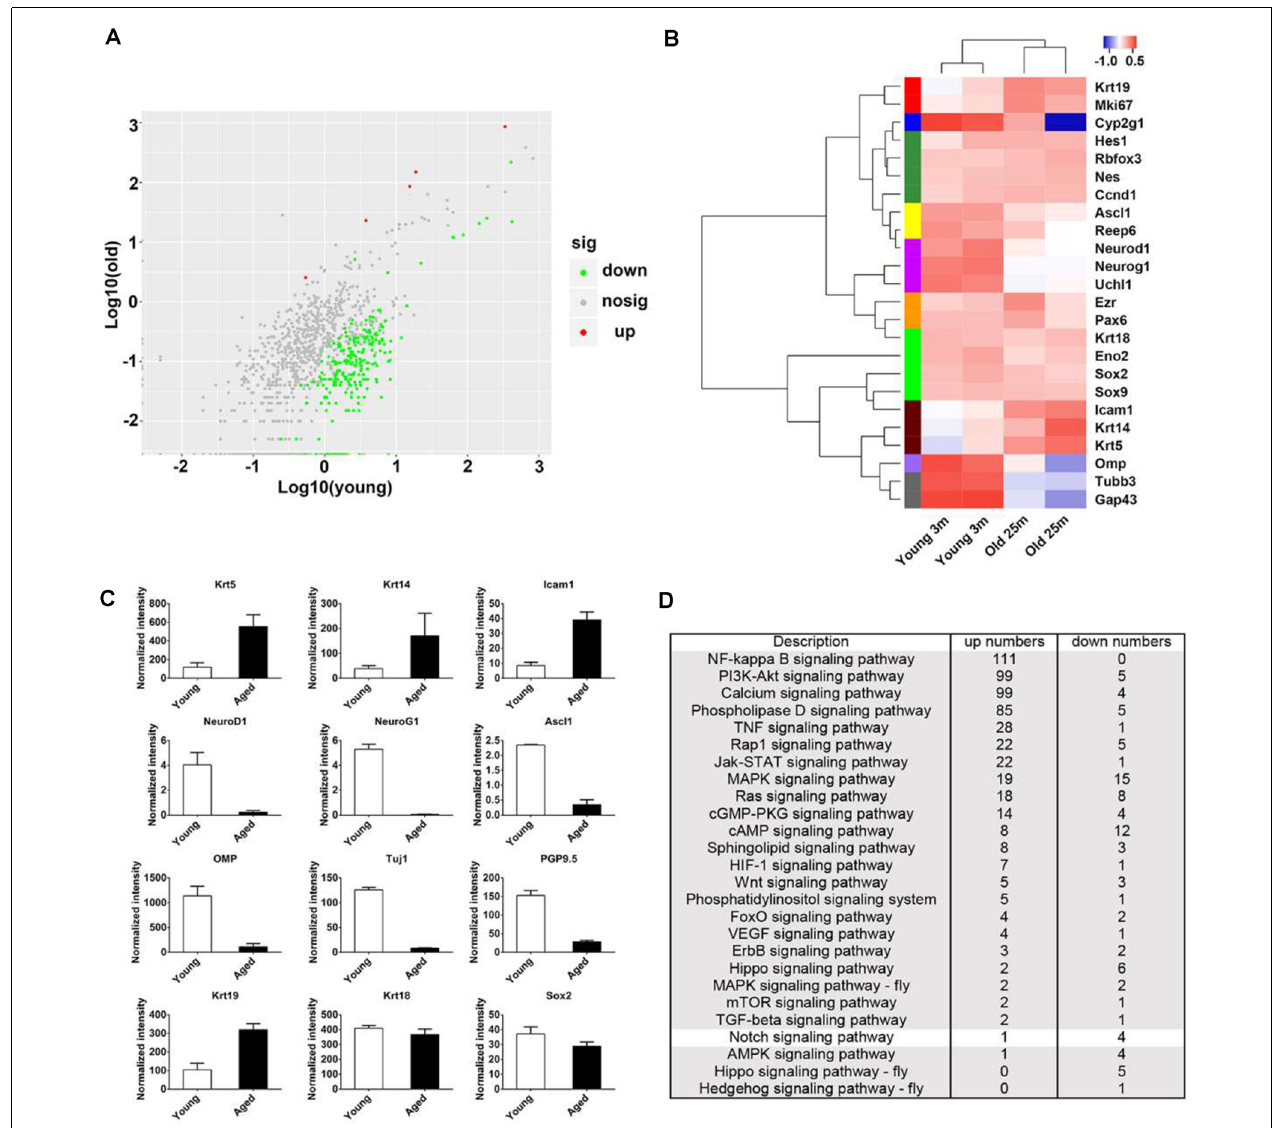
FIGURE 2 | Transcriptional analysis on the OE from young and aged mice at 3- and 25-month old. (A) Scatter plot showing the up- and downregulated as well as nondifferentially expressed genes in the OE from young and aged mice. (B) Heatmap showed the significantly differentially expressed biomarkers for cellular lineages in the OE from young and aged mice. (C) Statistical analysis of differential mRNA levels of OE biomarkers using RNA-seq data. (D) KEGG enrichment analysis indicated differentially expressed genes between the OE from young and aged mice participating in multiple signaling pathways including